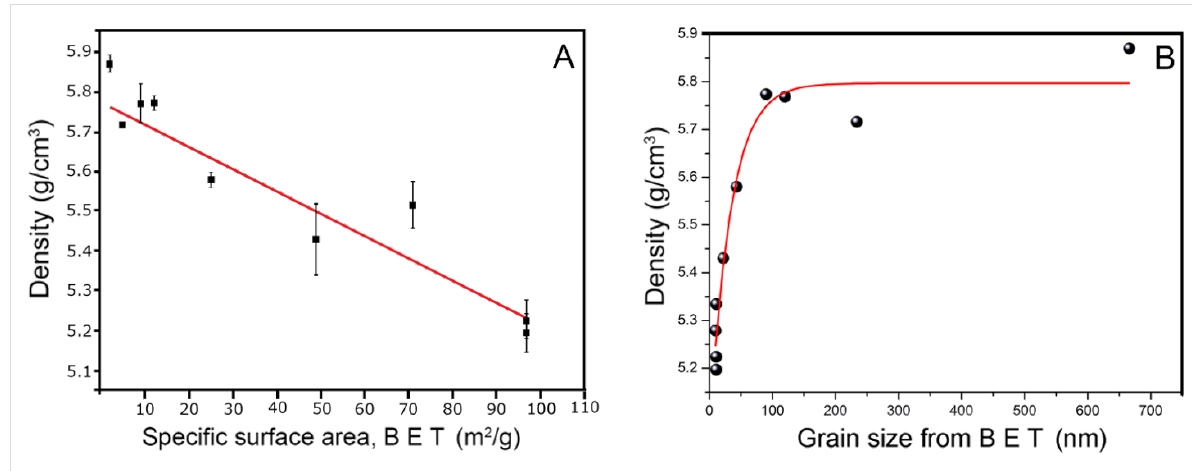
Figure 6: Density as a function of specific surface area (A), experimental and calculated correlation of density as a function of grain size from BET (B) for the nano-ZrO 2 .